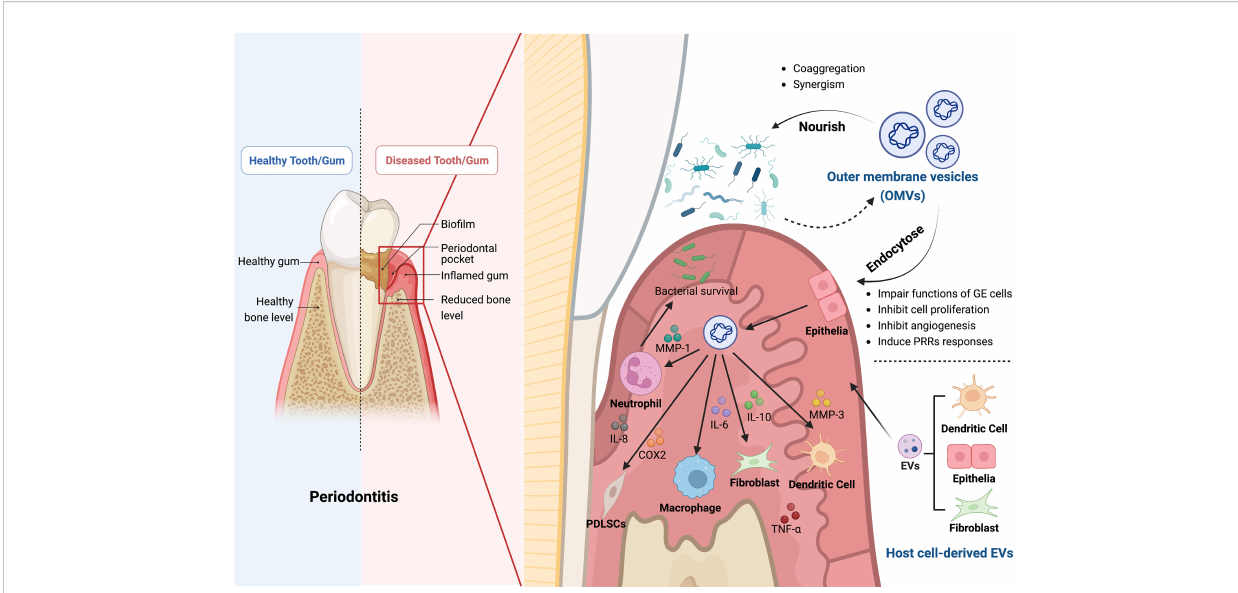
FIGURE 1 The roles of bacterial outer membrane vesicles (OMVs) and host cell-derived EVs in the pathogenesis of periodontitis. OMVs produced by Gram- negative bacteria contain bacterial components and bacterial products, such as outer membrane proteins, peptidoglycan, and lipopolysaccharide, which play a crucial role in the pathogenesis of periodontitis. Firstly, OMVs can enter the gingival epithelial cells through endocytosis and thus impair the function of gingival epithelial cells, inhibiting epithelial cell proliferation, slowing down angiogenesis, and inducing the response to